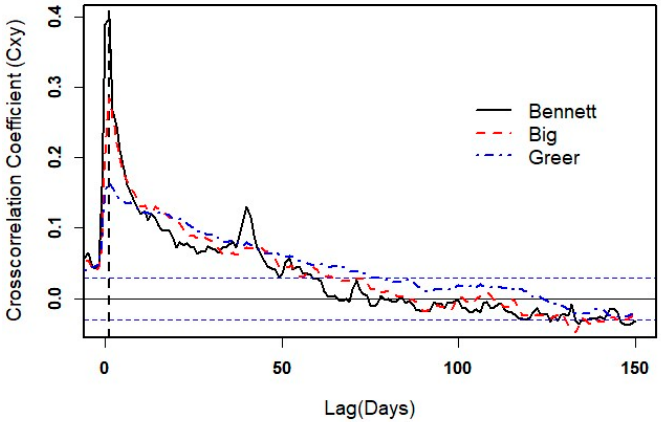
Figure 9. Cross-correlation plots for rainfall at adjoining stations and discharge at the studied springs for 2007–2019. The horizontal blue dashed lines represent the statistical significance at 95% of confidence intervals.